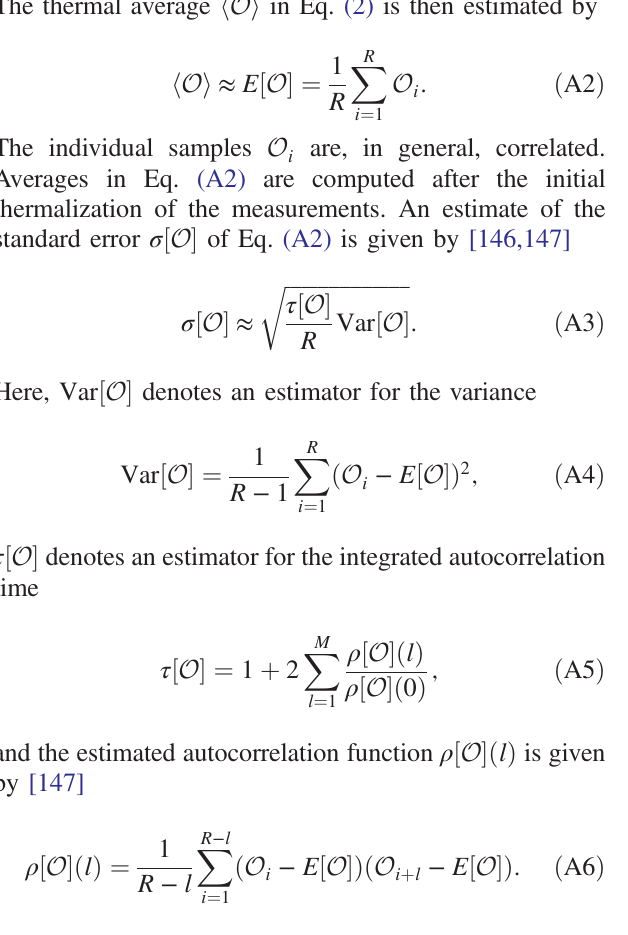
ffiffiffiffiffiffiffiffiffiffiffiffiffiffiffiffiffiffiffiffiffiffiffi τ ½ O (cid:4)